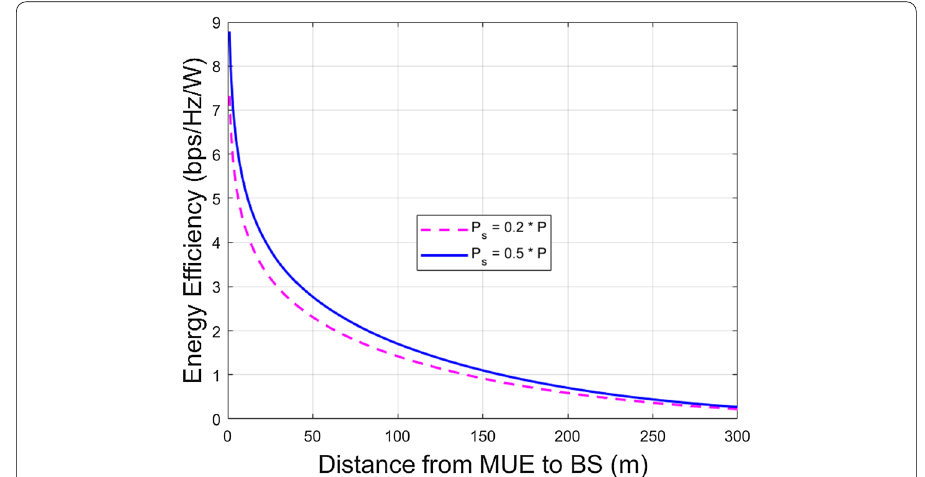
Fig. 17 energy efficiency vs. distance from MUE to BS in uplink